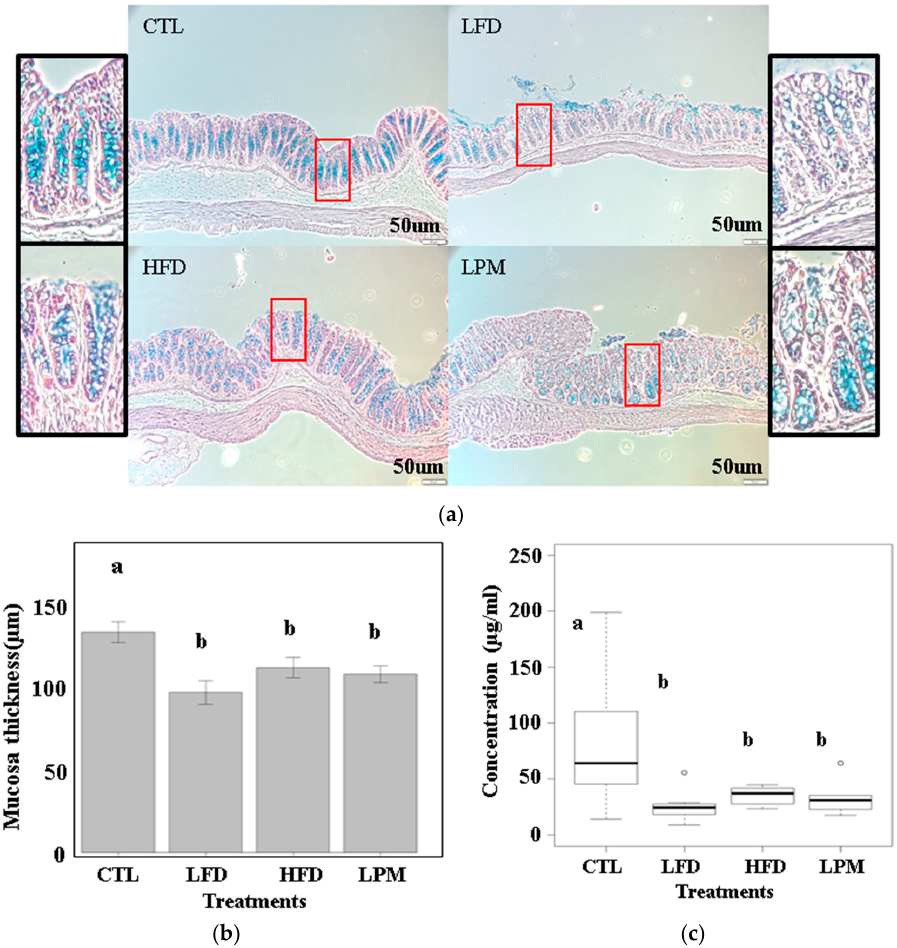
Figure 1. Mucosa thickness and concentration of butyrate: ( a ) histological images of intestinal tissue; ( b ) mean values ( n = 3) of mucosa thickness; and ( c ) concentration of cecum butyrate. Different letters on bars indicate significant difference ( p < 0.05) according to the Duncan’s multiple range test.